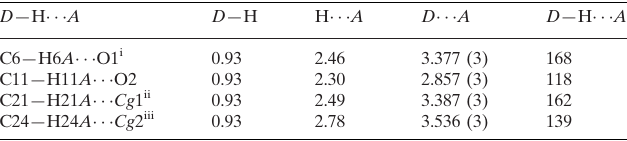
Data collection Bruker APEXII DUO CCD area- detector diffractometer Absorption correction: multi-scan ( SADABS ; Bruker, 2009) T min = 0.949, T max = 0.993